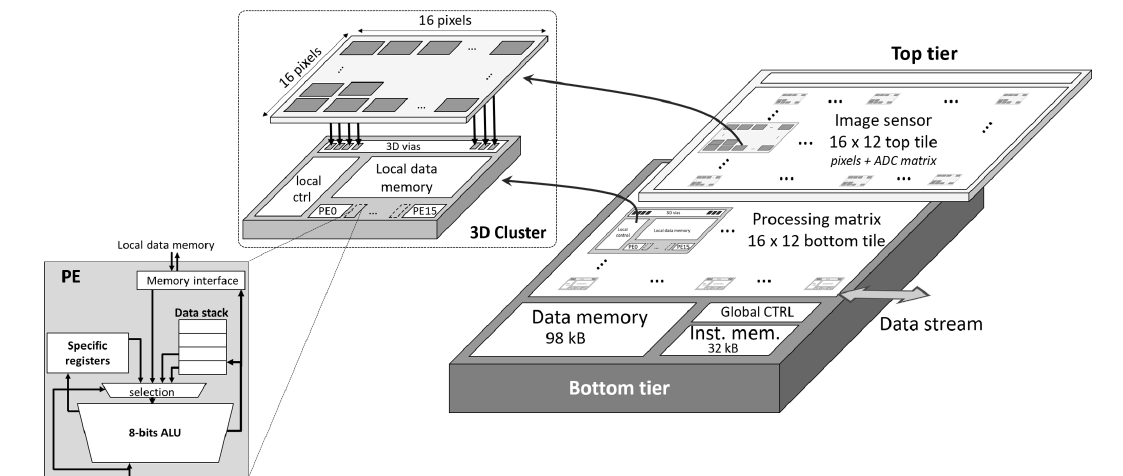
Figure 1. Three-dimensional-stacked macropixel processor array overview: ( top left ) 3D-stacked macropixel array with 16 × 16 pixels tightly coupled to a SIMD of 16 PEs ( bottom left ). Details of one PE ( right ). A full matrix of MPX-p.